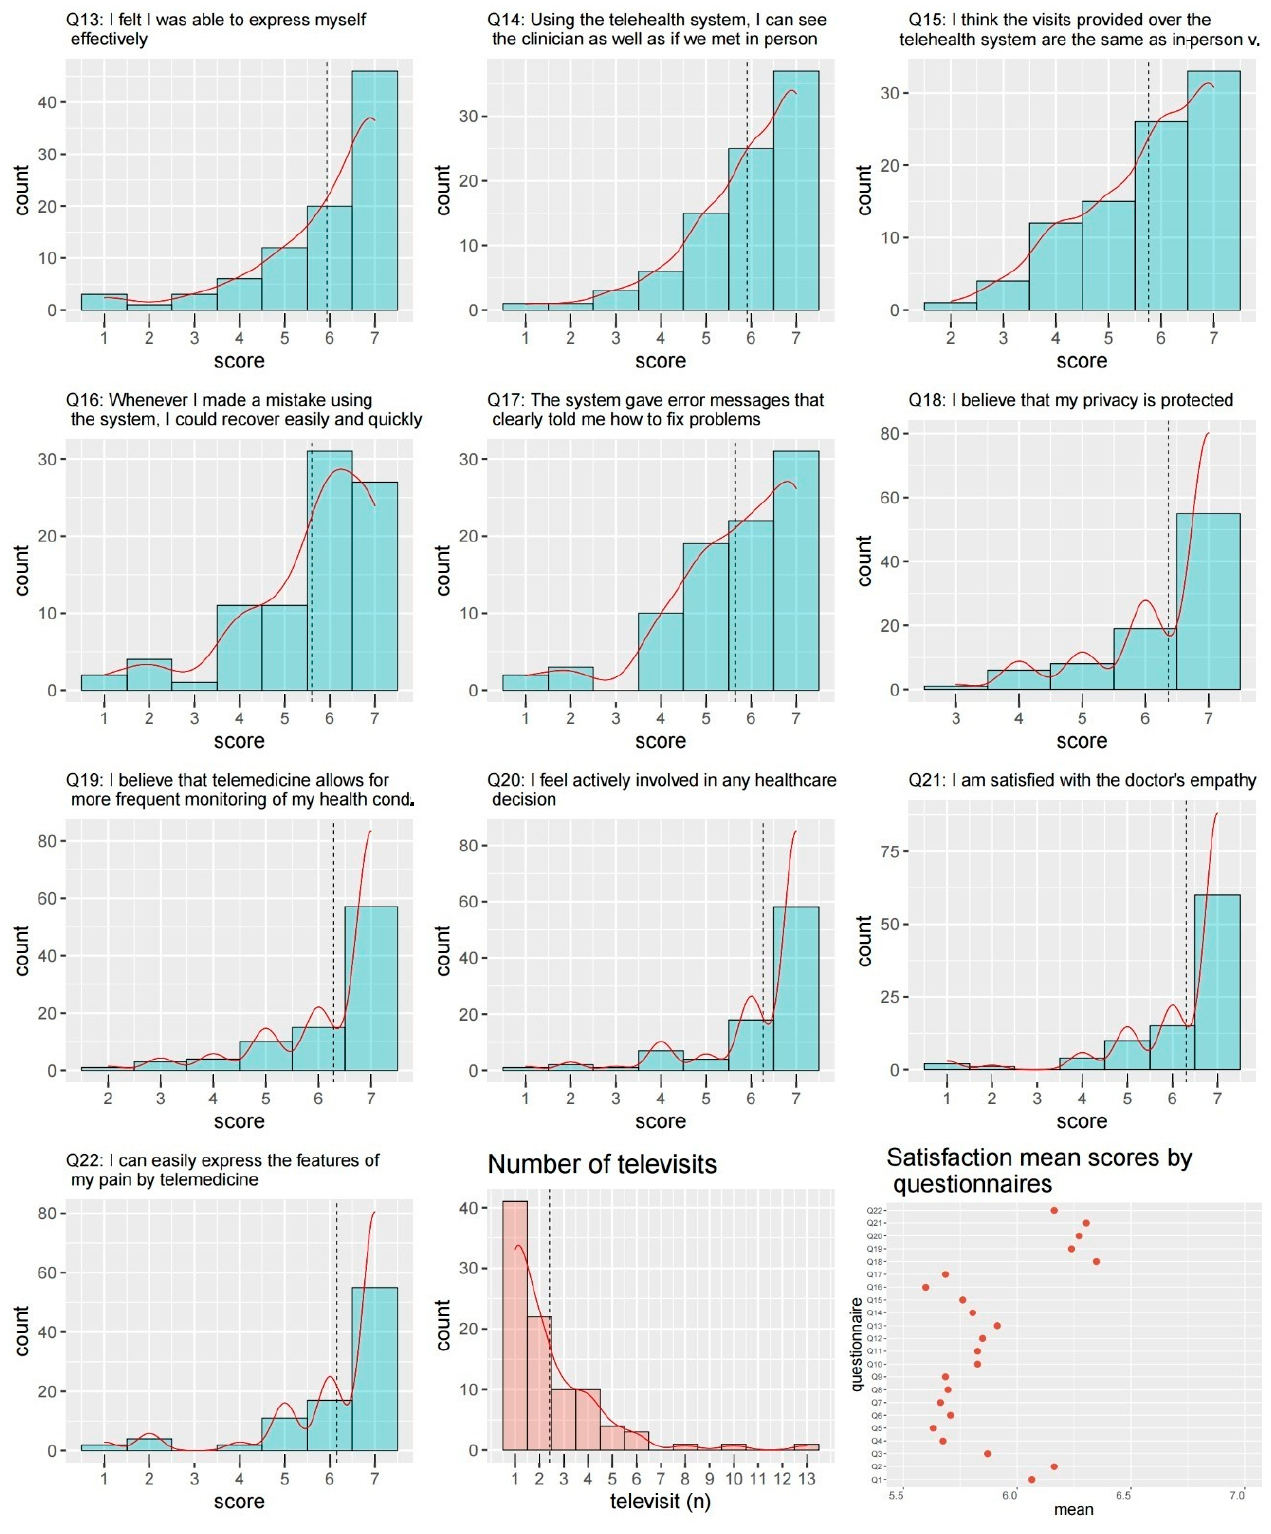
Figure 4. Patient satisfaction questionnaire (items 13–22). The questions were answered using a 7-point Likert scale (i.e., from “strongly disagree” = 1, to “strongly agree” = 7). The dashed lines indicate the mean values. The figure also reports the number of video consultations for a patient and the mean values for each item.